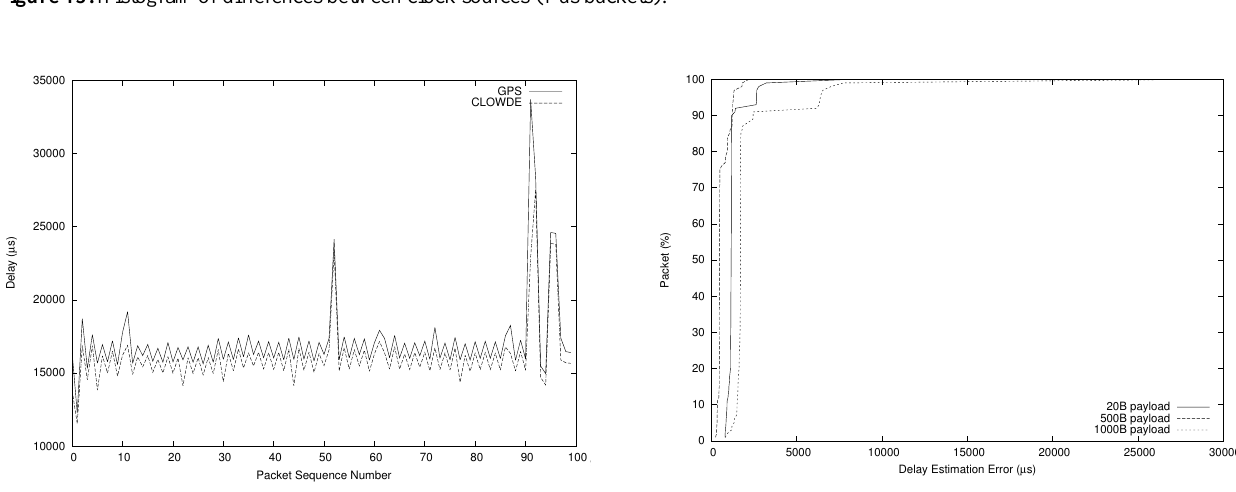
Table 3: Sampling time accuracy among 3 nodes